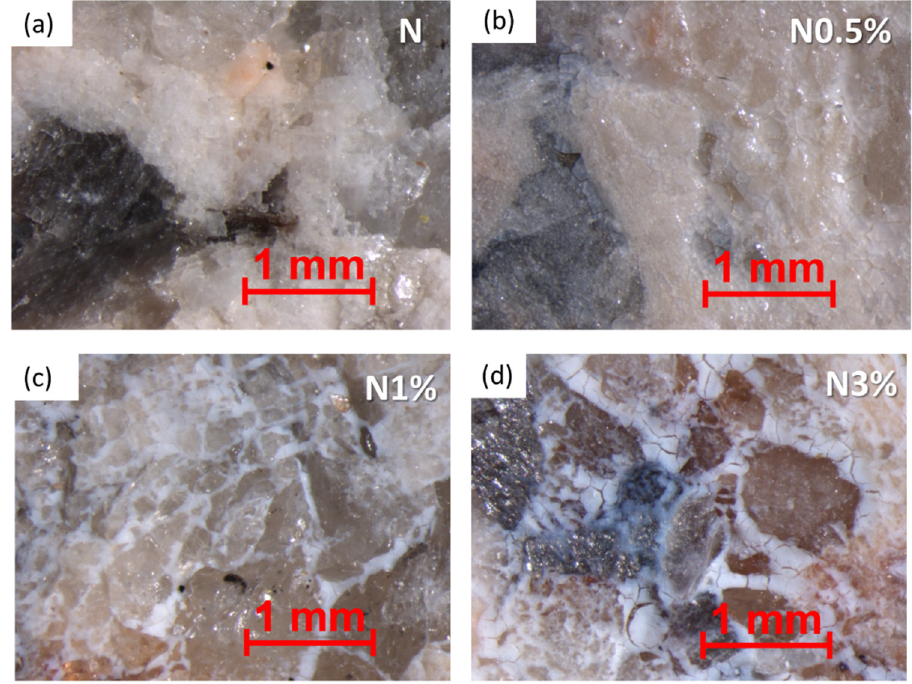
Figure 3. Micrographs taken with stereomicroscopy of the surfaces covered with the nano-sized silica-based consolidant Nano Estel and the different TiO 2 nanoparticles concentration ( a : 0%; b : 0.5%, c : 1%, and d : 3%). Check Table 1 to understand the acronym.